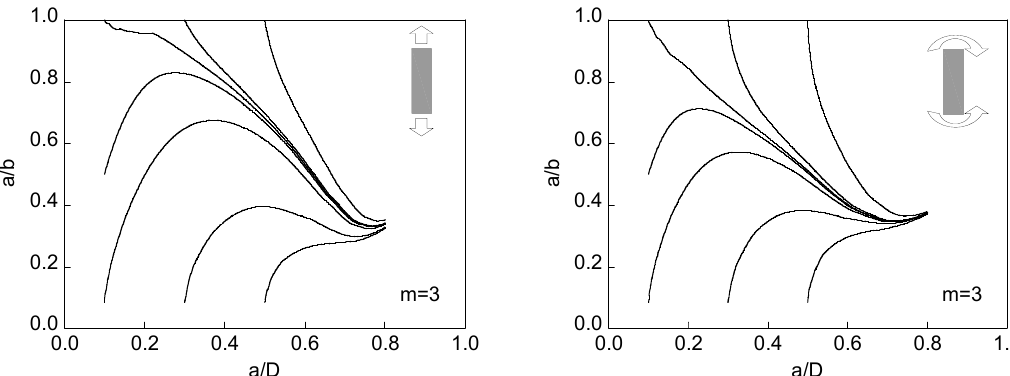
Figure 6: Evolution of the aspect ratio a / b with crack growth (represented by the relative crack depth a / D ) for m =3, starting from different initial crack geometries under tension loading (left) and bending moment